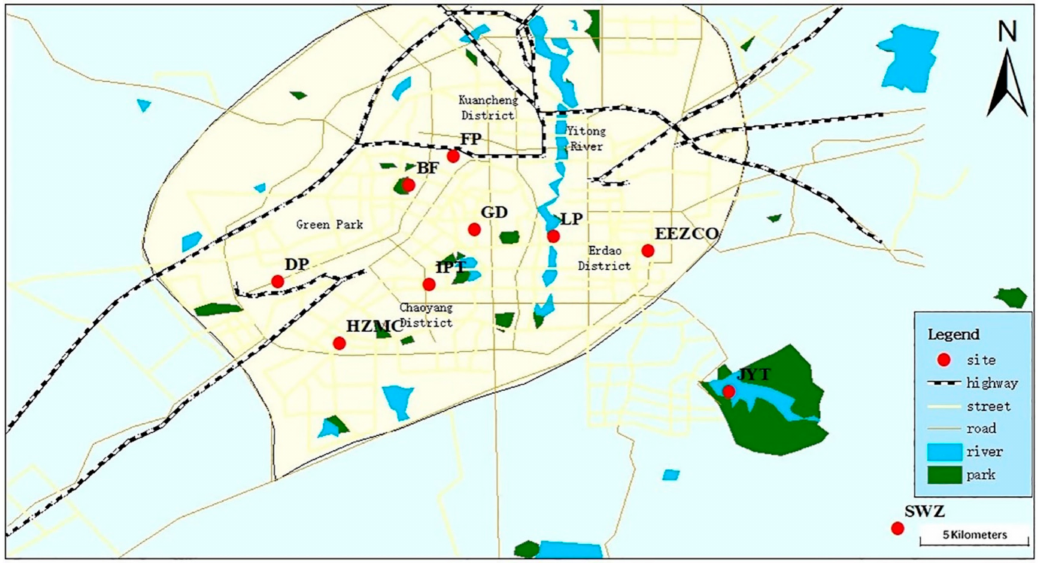
Figure 1. Air monitoring stations of